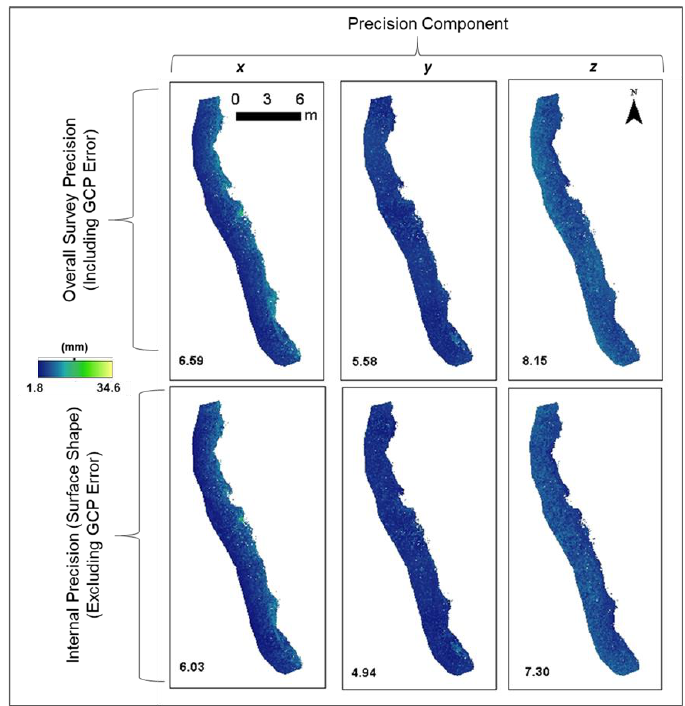
Figure 12. Precision error maps separated into x , y and z dimensions for Crosby. Overall survey precision including georeferencing error and internal precision (surface shape error) excluding any georeferencing error are displayed in two rows. Mean precision (mm) is displayed on the bottom left of each map.